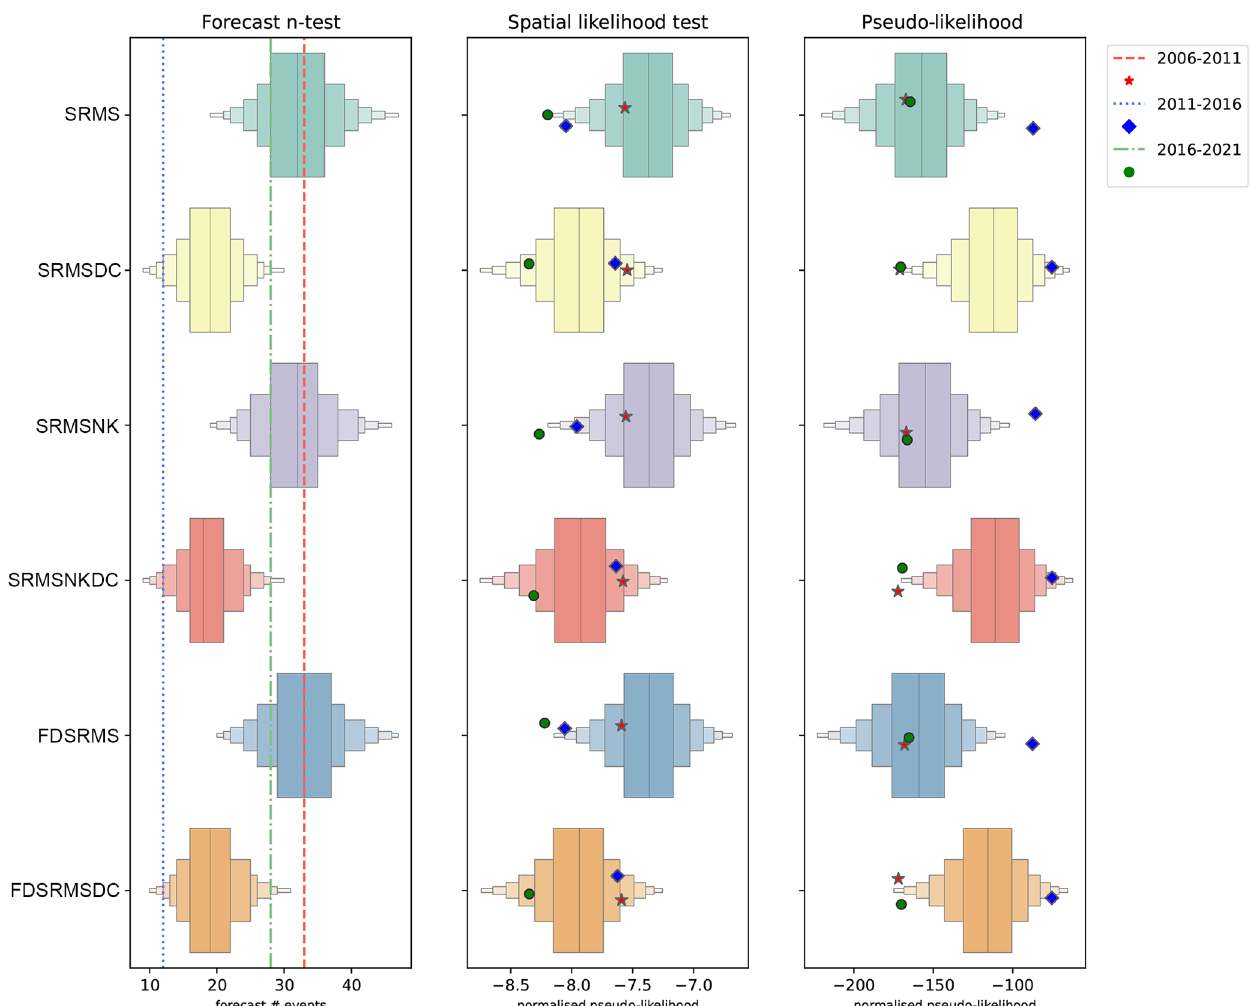
Figure 8. N test, S test and pseudo-likelihood results for each of the 6 inlabru models when forecasts are generated from 10000 synthetic catalogues sampling from the full inlabru model posteriors. For the N test, the number of observed events for the 2006–2011, 2011–2016 and 2016–2021 are shown by the red, blue and green dashed lines, respectively. For the S and pseudo-likelihood tests, the observed test statistic for each time period is shown as a symbol (red star for 2006–2011, blue diamond for 2011–2016 and green circle for 2016–2021). Models include combinations of smoothed past seismicity (MS), strain rate (SR), fault distance (FD) and fault slip rates (NK), where DC indicates a model built with a declustered